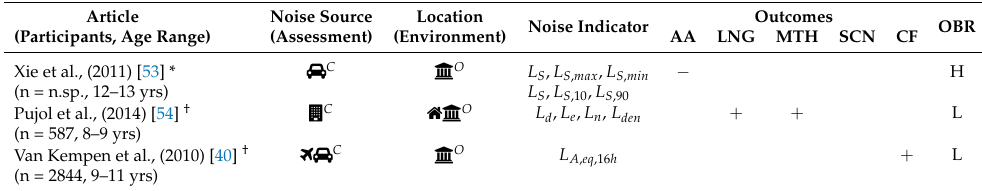
Table 8. Cognitive performance-based studies. AA corresponds to academic achievements, LNG to language, MTH to mathematics, SCN to science, and CF to cognitive functioning. For an explanation of symbols and notations, see the caption of Table